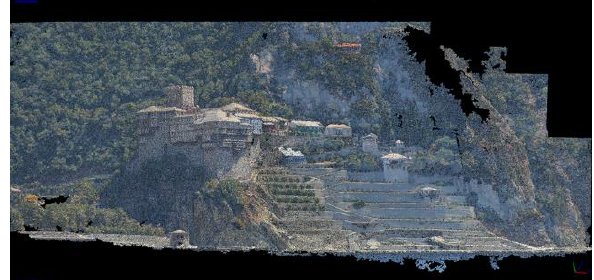
Figure 3 . The Monastery of St. Dionysius. Cloud of points.